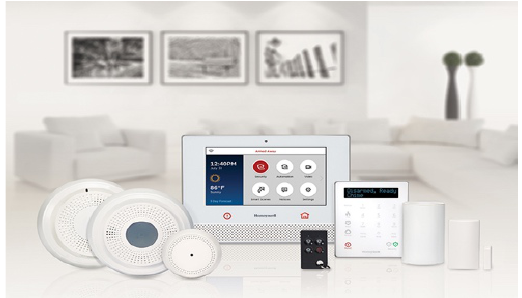
Figure 1 . An ecology of devices in the smart security system.